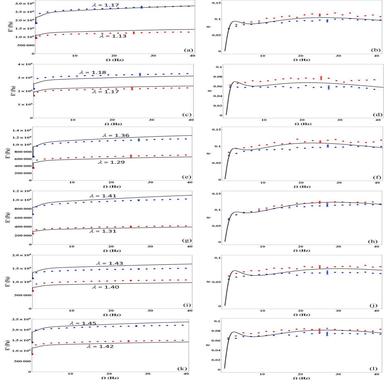
Storage modulus E and loss tangent η at two different initial stretches λ on the axial and circumferential strips from intima, media and adventitia from donor IV versus loading frequency Ω (Hz). The error bar quantifies the estimated measurement error. , experimental data for the smallest stretch; , experimental data for the largest stretch; —, generalized Maxwell material model with NS=3. (a) Storage modulus for axial intima; (b) loss tangent for axial intima; (c) storage modulus for circumferential intim